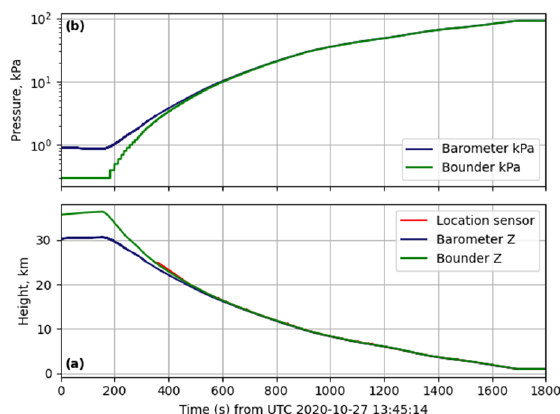
Figure 4. Comparison of the ( a ) height above the ellipsoid and ( b ) absolute pressure in the Bounder and S10.